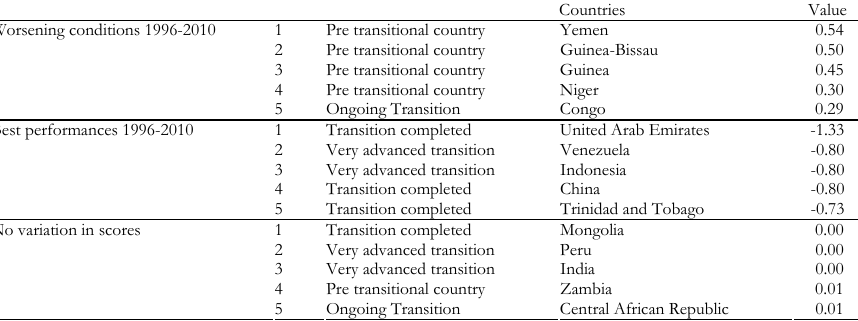
Extreme scores for variation on factor 2 - Macroeconomic conditions and deprivation 2010- 1996 Countries Value 1 Pre transitional country